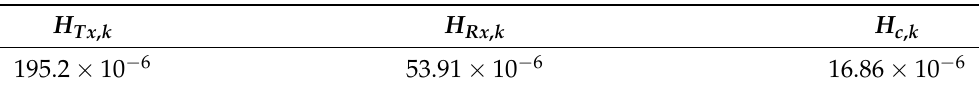
Figure 21. Mean squared error H T Table 4. Mean squared error H T